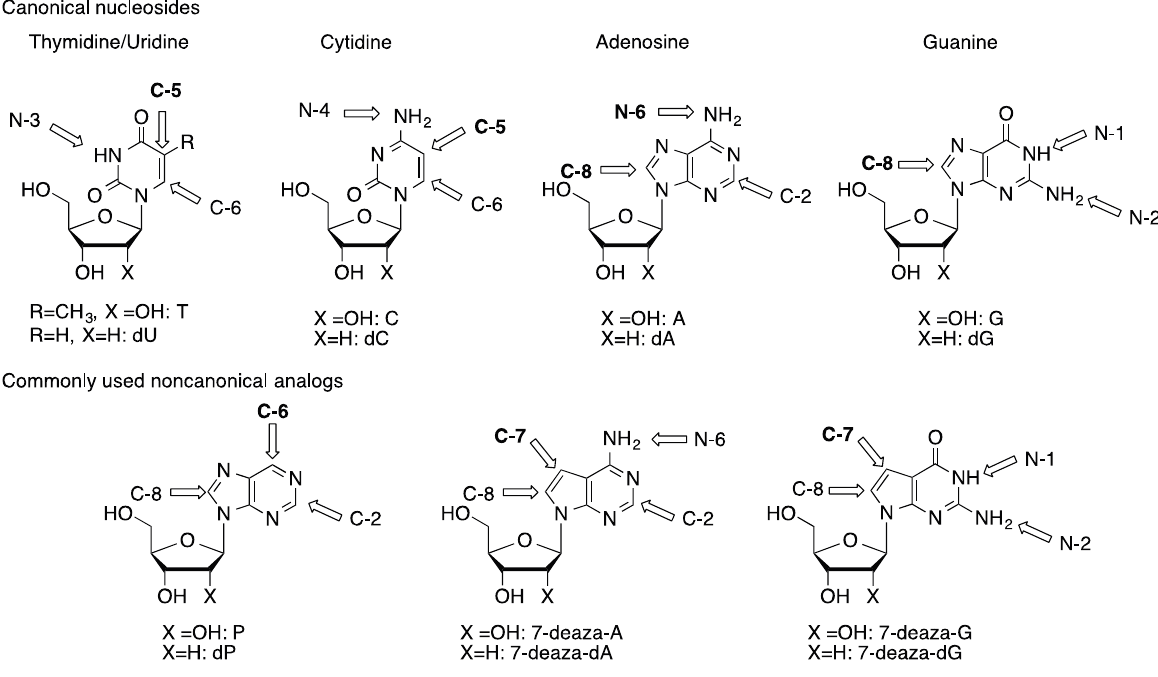
Figure 1. Typical functionalization sites in naturally occurring nucleosides and commonly used unnatural analogs. Most common functionalization sites are